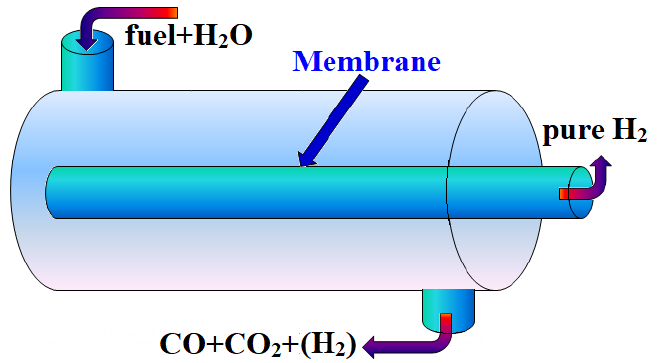
Figure 9. Scheme of hydrogen production with the use of membrane catalysis.